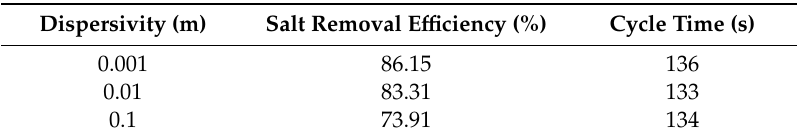
Table 3. E ff ects of dispersivity on the maximum salt removal e ffi ciency and the corresponding cycle time of MCDI.